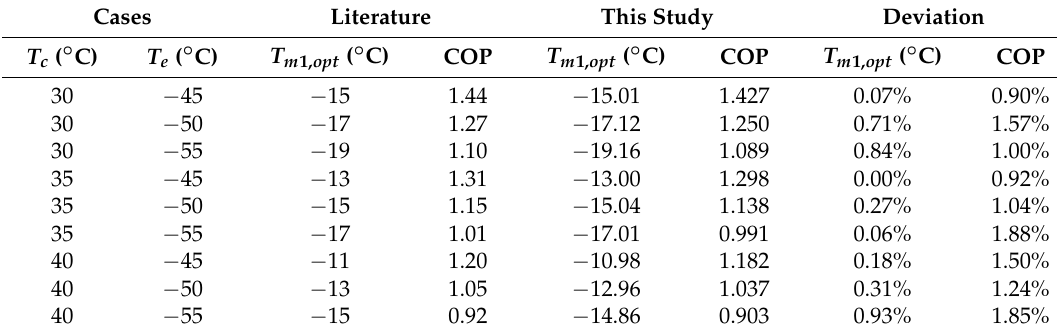
Table 2. Model validation with literature data [24].